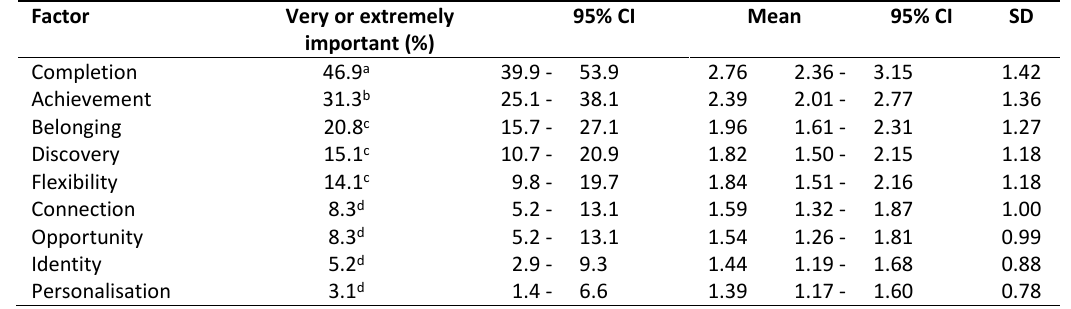
Table 2: Importance of factors in having a successful university experience (QV method)